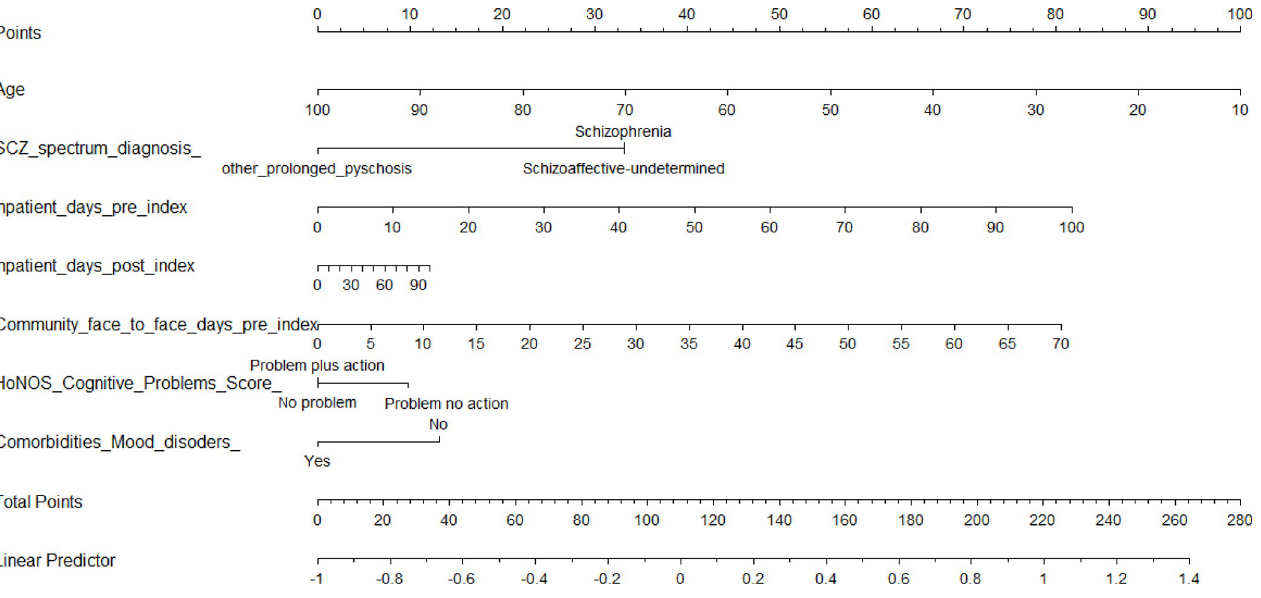
indexes, given by the linear predictor line, for TRS. The coefficients are based on the Lasso Cox model. The nomogram allows us to compute the normalized prognostic index (PI) for a new patient. The PI is a single-number summary of the combined effects of a patient’s risk fac- tors and is a common method of describing the risk for an individual. In other words, the PI is